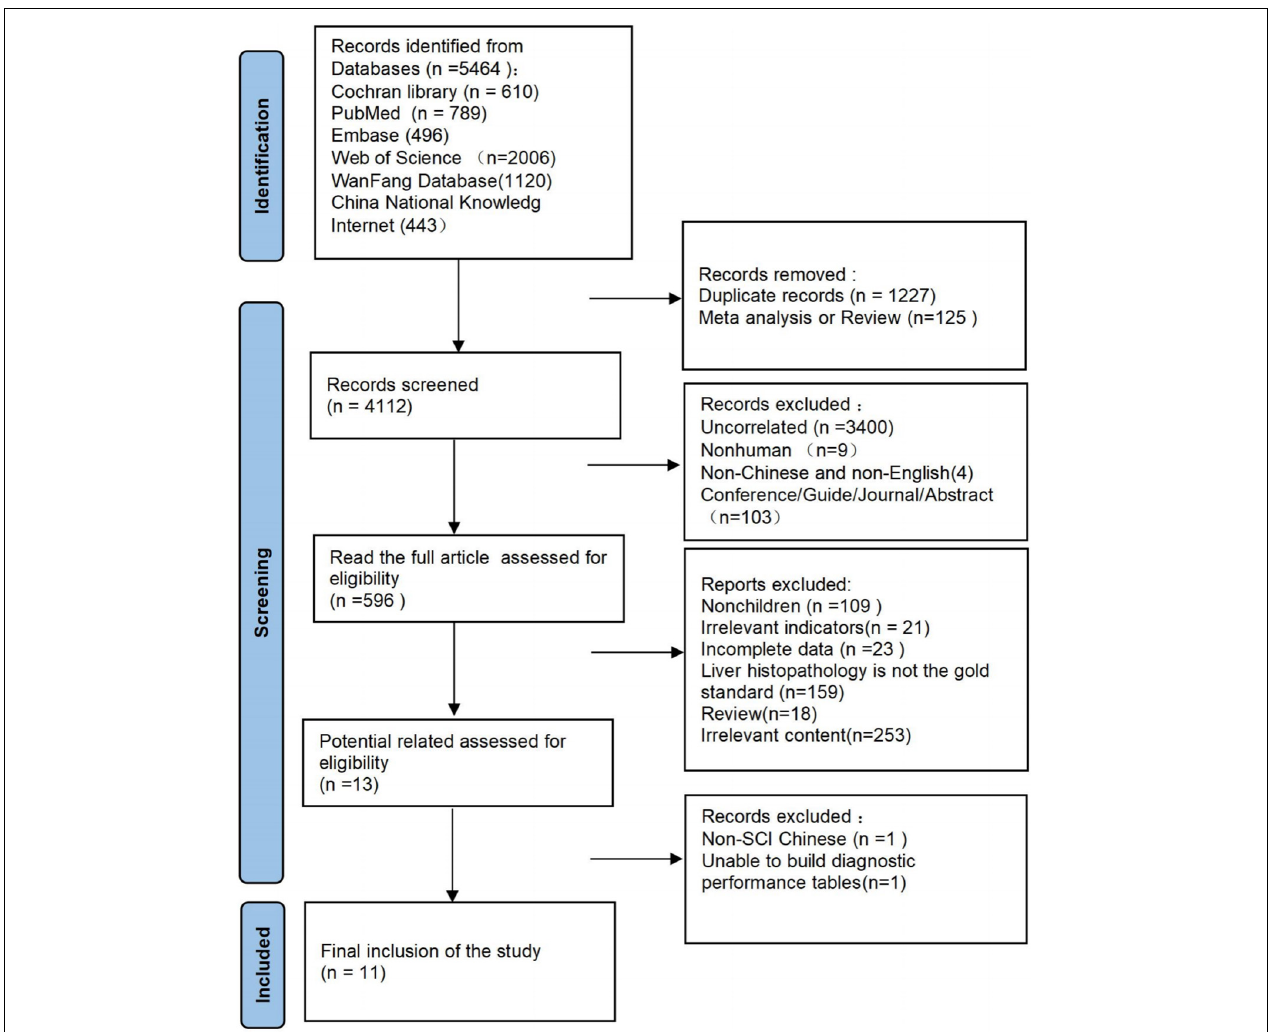
FIGURE 1 | Flow diagram of study selection